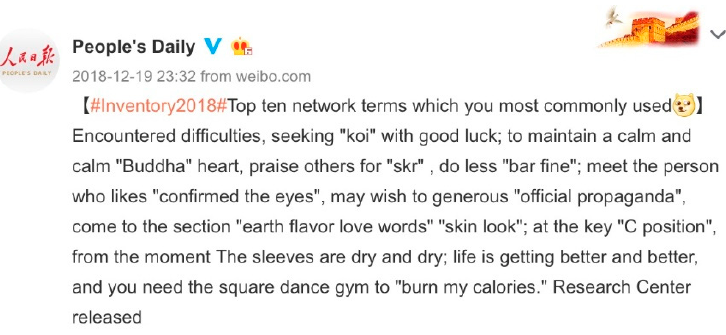
Figure 2. News from Netease News.